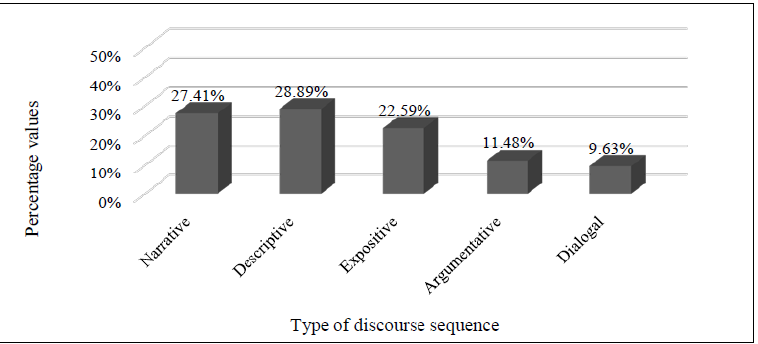
Figure 9. Percentage values of vamos according to the type of a speech act in which it appears. Table 7. Combination of the vamos marker with other connection